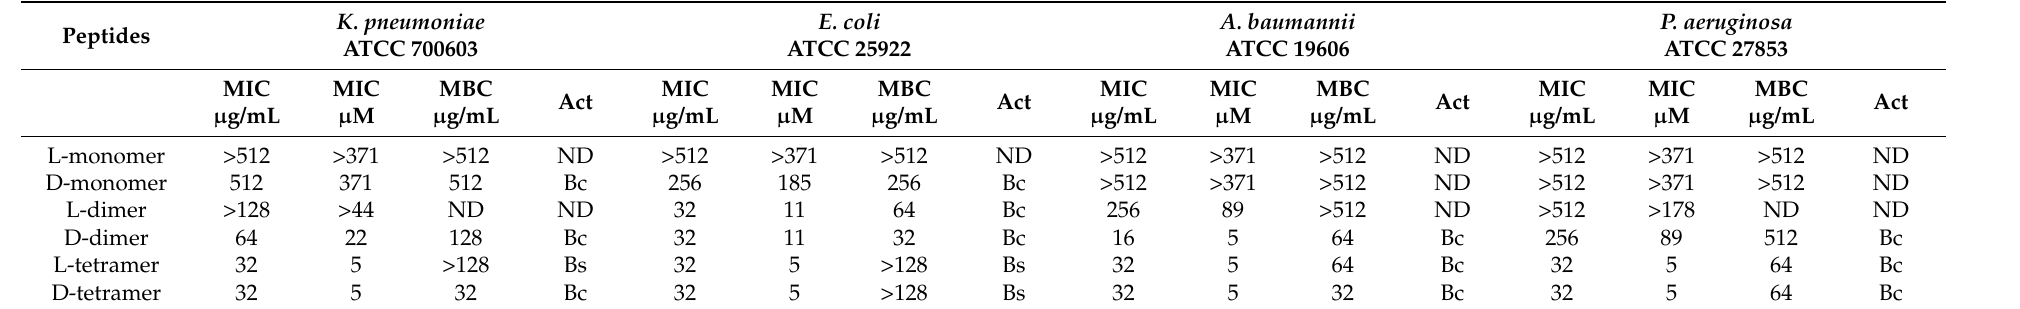
Table 2. Minimal inhibitory, bactericidal concentration and antibacterial activity of p-BthTX-I analogs against Gram-negative